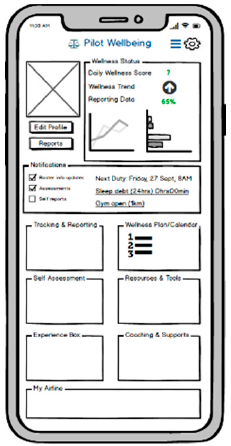
Figure A8. Tool 1: dashboard.